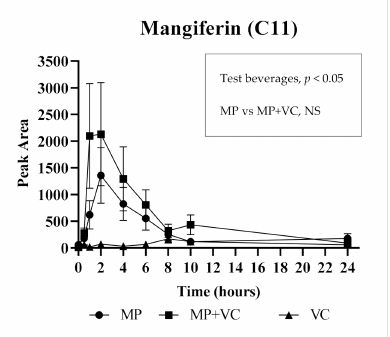
Figure2. Areavs. timeprofile(0 − 24h)ofmangiferin( C11 )aftertestbeveragesintake. Theconcentration of mangiferin was below the limit of quantitation (LOQ). MP (mango pulp), MP + VC (mango pulp + vitamin C) and VC (vitamin C). NS: not